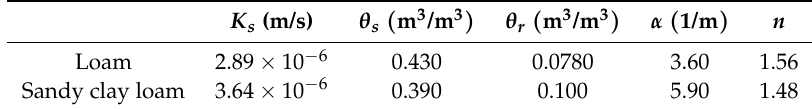
Table 1. The parameters of the investigated 3D